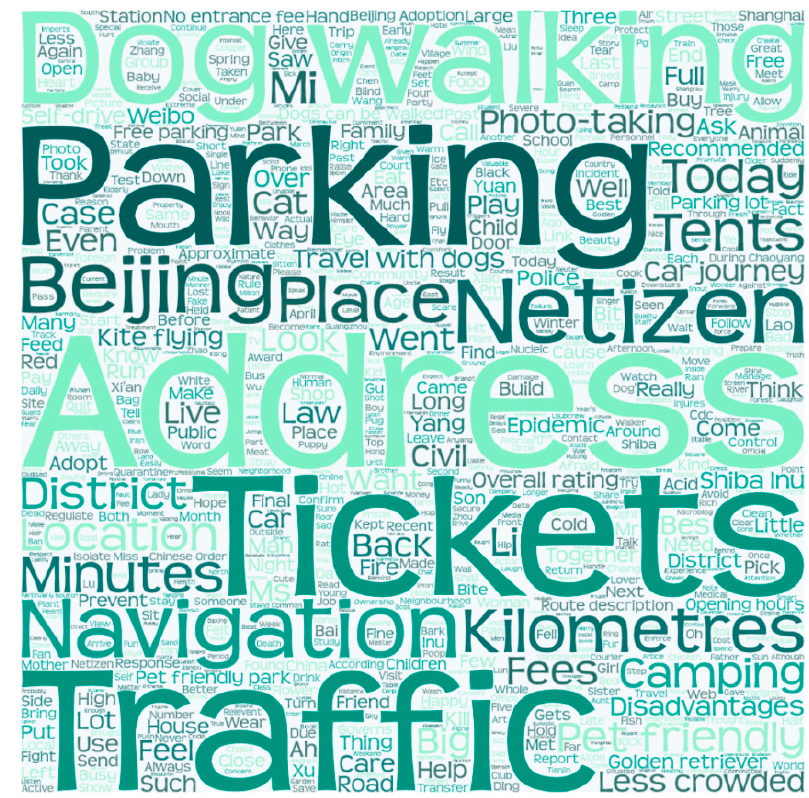
Figure 2. Perceptive word cloud map (before the outbreak).